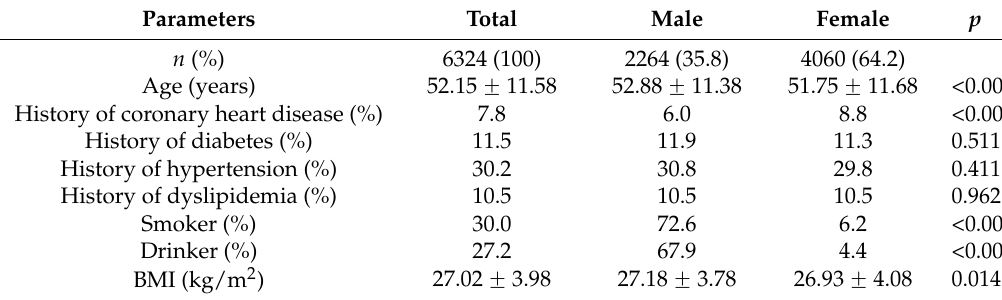
Table 1. General characteristic of